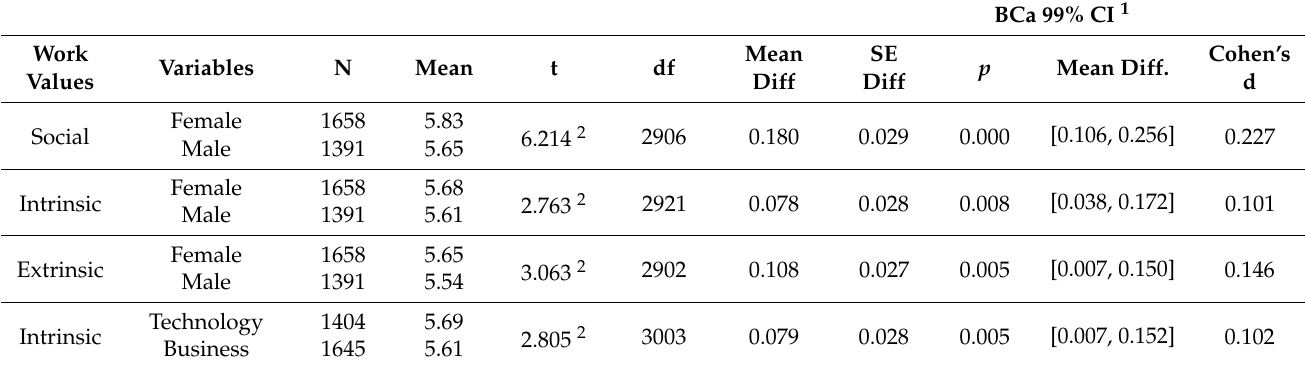
Table 7. Significant differences in work values according to students’